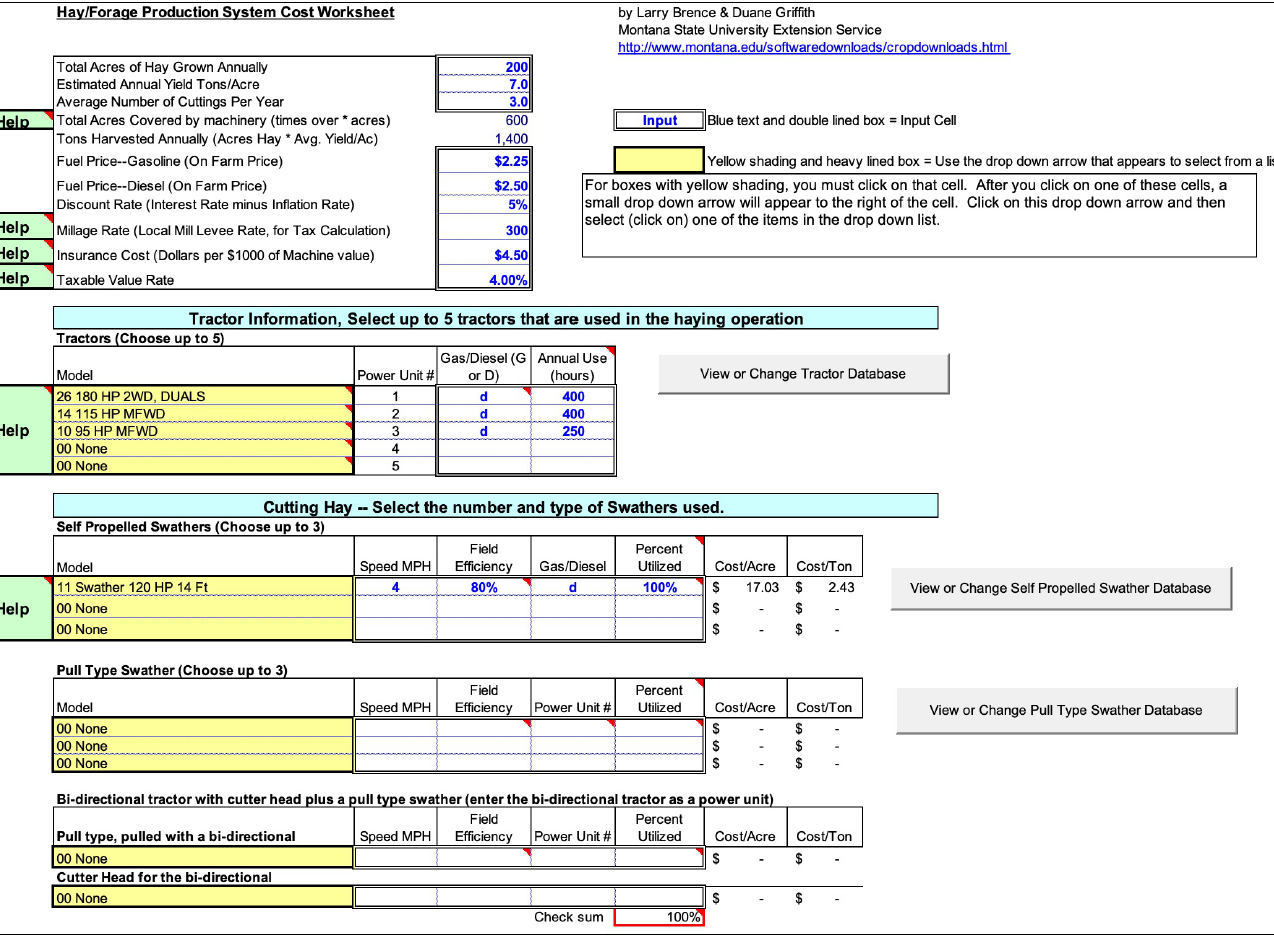
Figure 11. Haying system budget estimator developed by Montana State University Extension. The functions of the colored cells were indicated in the